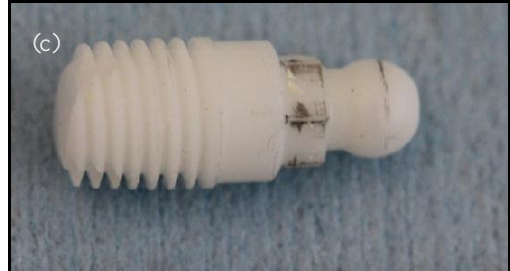
Figure 2. Clinical examples of fractured zirconia implants: ( a , b ) implants fractured during surgery; ( c ) implants fractured after prosthodontic